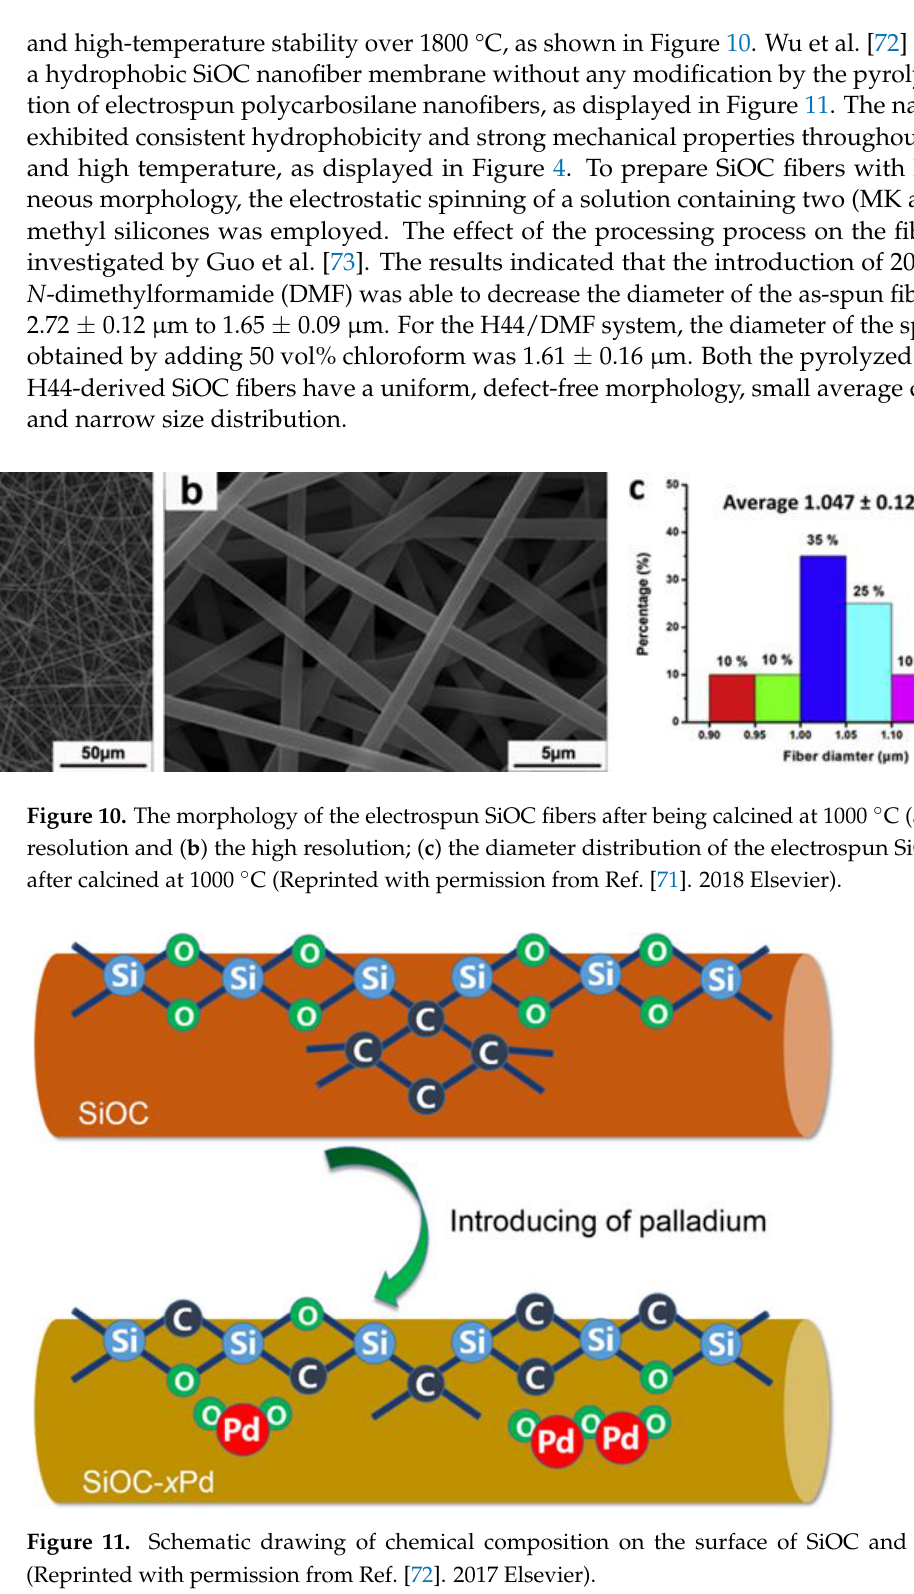
12 Figure 9. Fabrication procedure illustration of N-doped hollow SiC fibrous mats (Reprinted with permission from Ref. [69]. 2013 Royal Society of Chemistry). Wang et al. [71] used electrospinning technology to obtain ultrafine ZrO 2 /SiC fibers. By pyrolysis at different temperatures, the fibers possessed a radial gradient composition and high-temperature stability over 1800 ℃, as shown in Figure 10. Wu et al. [72] obtained a hydrophobic SiOC nanofiber membrane without any modification by the pyrolysis re-